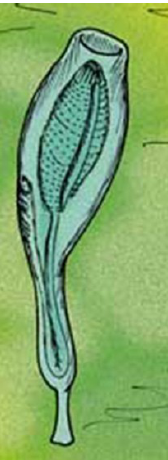
Figure 4. Cambrian tunicate Shankouclava anningense . The animal is 4 cm in height. Image credit: Apokryltaros. Used here per CC BY-SA 3.0.